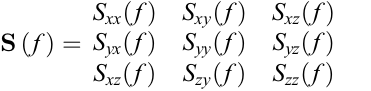
Fig. 4. A nightside pass through the auroral zone and the polar cap, on 27 October, 1996, showing wave emissions in the three frequency bands. The figure is a copy of the electric view of the MEMO Quick Look data (see text). The time interval between two time marks is 2 min 30